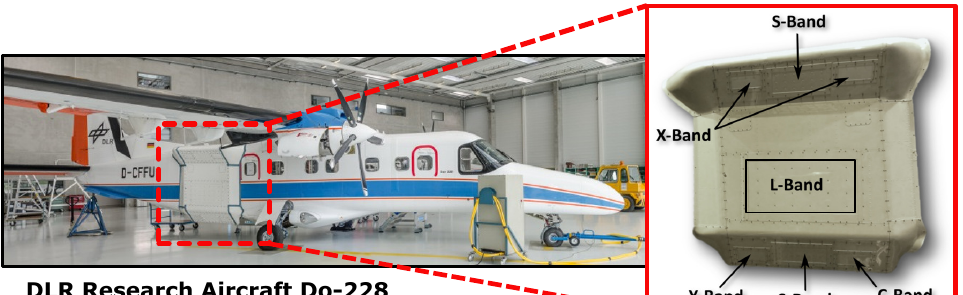
Figure 1. F-SAR Antenna